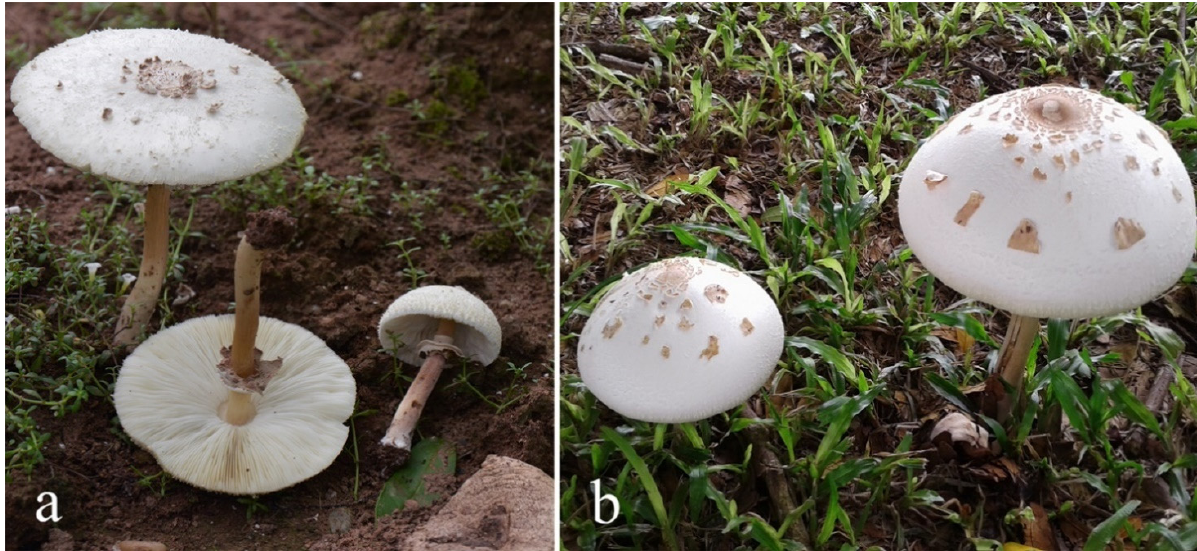
Figure 11. Fresh basidiomata of Chlorophyllum molybdites in situ. ( a ) MFLU 12-1775. ( b ) MFLU 12-1819.